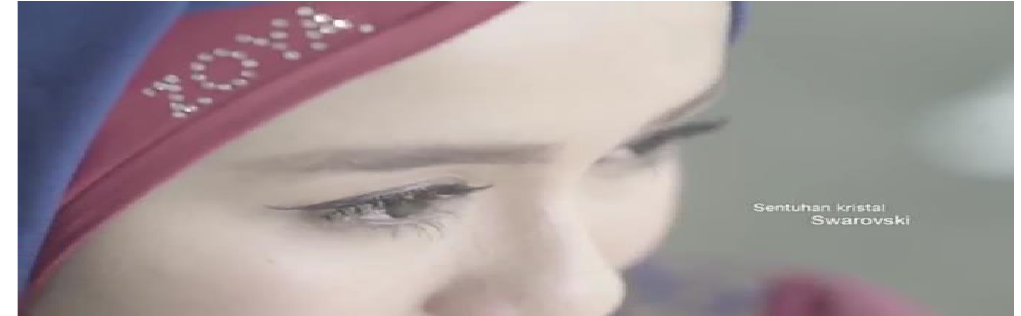
Figure 1: An Elegant Muslim Woman Physical